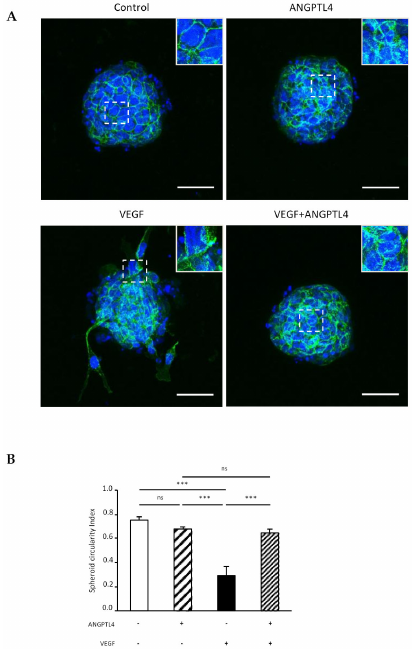
Figure 4. Regulation of VE-cadherin and endothelial spheroid integrity by ANGPTL4 and VEGF. ( A ) Endothelial spheroids treated without or with ANGPTL4 (2.5 µ g/mL) and/or VEGF (50 ng/mL) for 24 h. Spheroids were fixed and labelled for VE-cadherin (green) and nuclei (blue). White boxed areas are presented in top right insert. Scale bar: 50 µ m. ( B ) Mean values of spheroid circularity index (+SEM). Values were measured in three independent experiments. ns: p > 0.05, *** p ≤ 0.001 (one-way